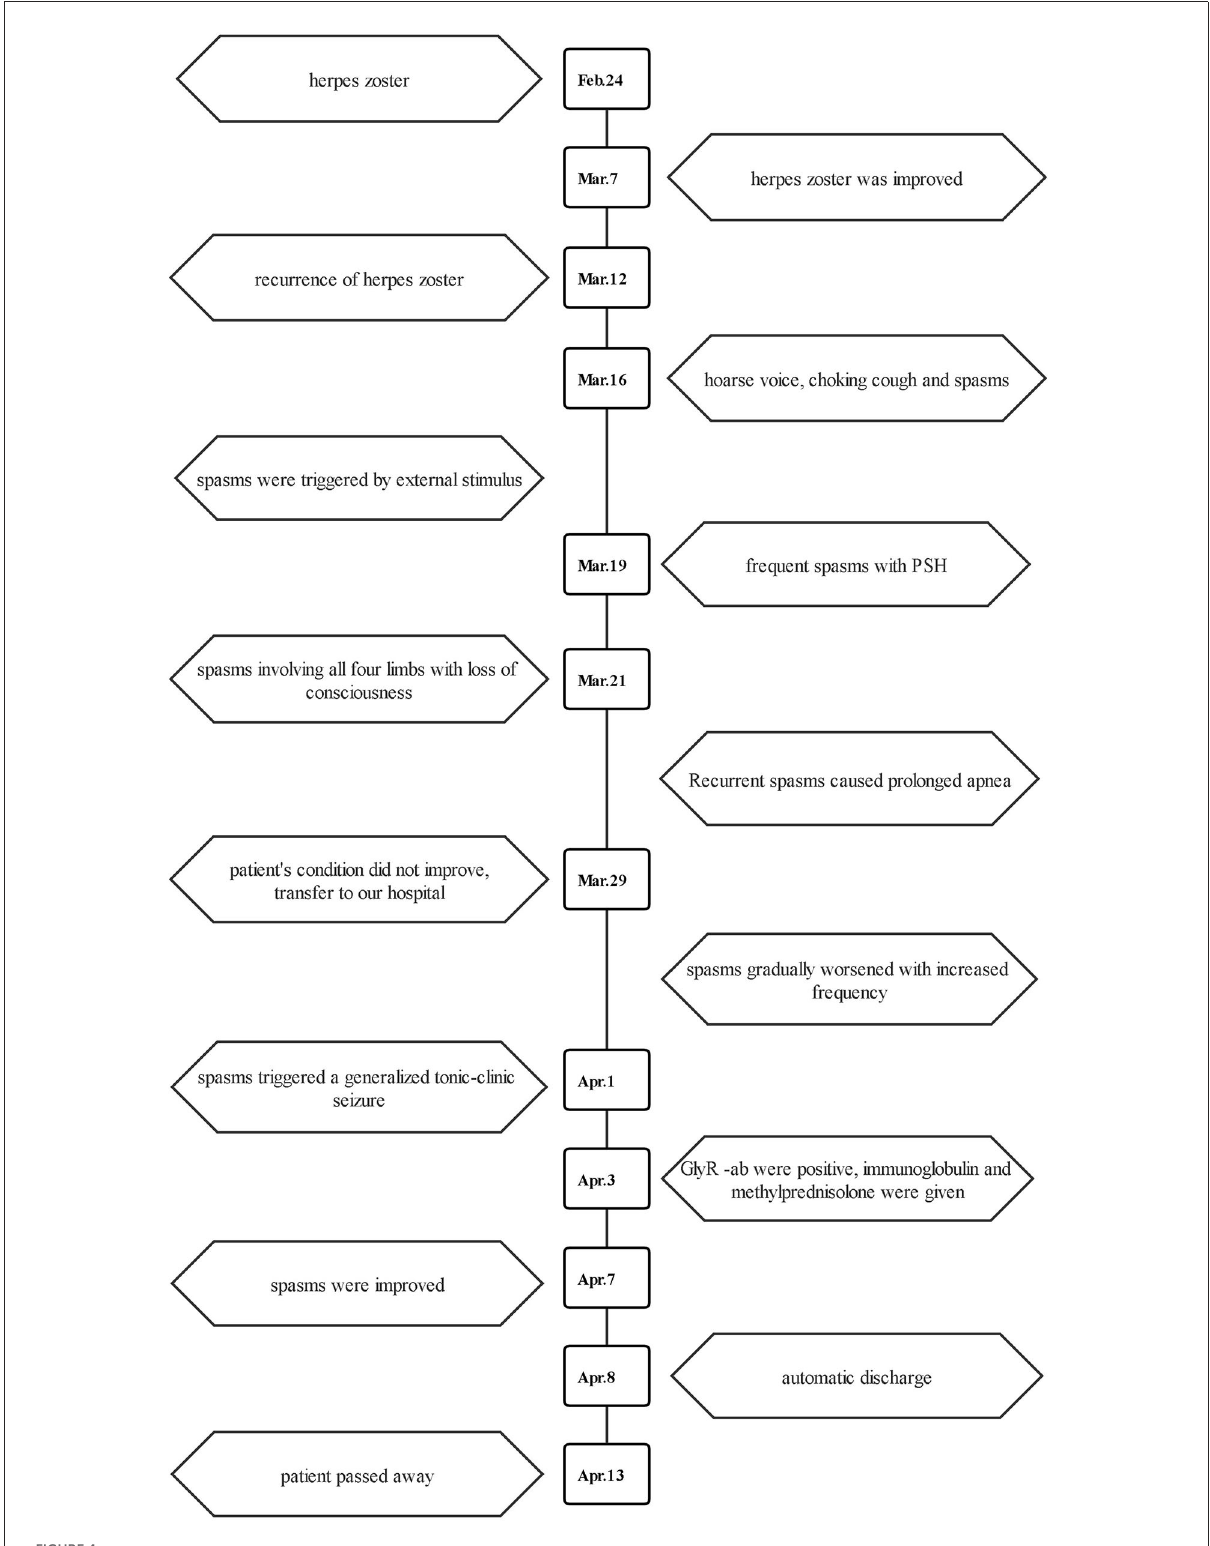
FIGURE4 A schematic showing the timeline of the patient’s